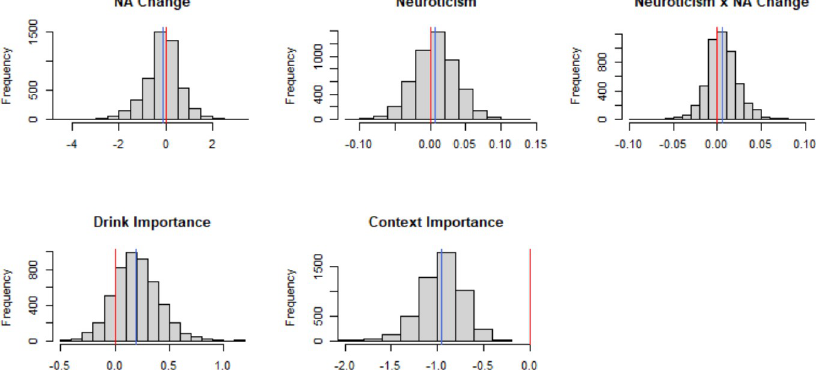
Fig 2. Histograms of the distribution of the bootstrapped coefficients. Blue line=mean of bootstrapped coefficients; red line=zero.